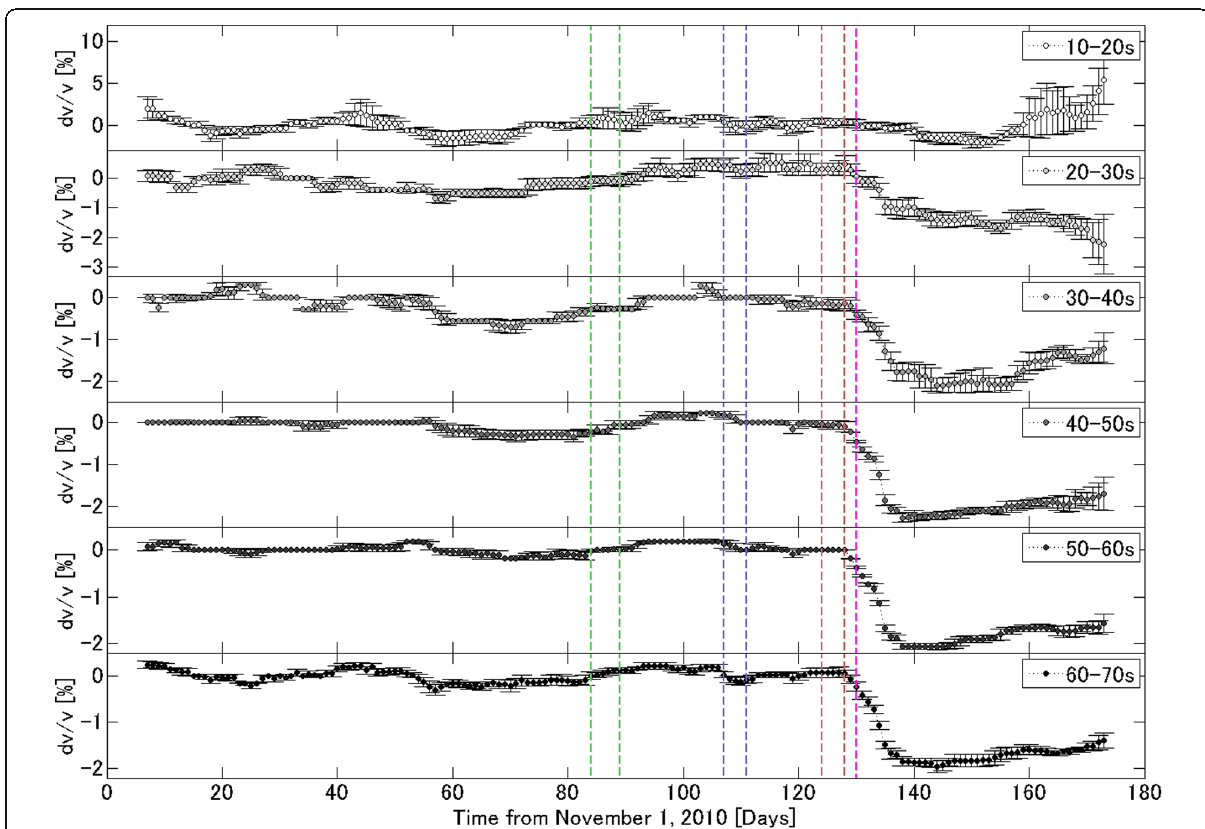
Fig. 5 Temporal variations in seismic velocity at S09. These figures show the temporal velocity changes calculated from the phase delays at each lapse time: from 10 – 20 s, 20 – 30 s, 30 – 40 s, 40 – 50 s, 50 – 60 s, and 60 – 70 s. The four colors of broken lines correspond to the occurrence of